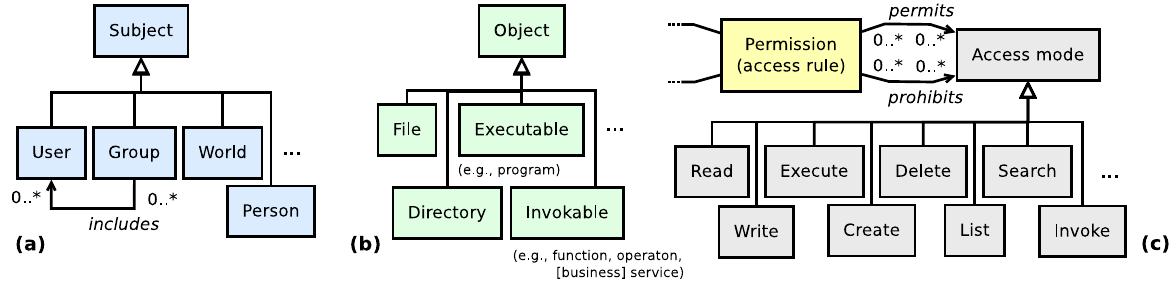
Figure 1. Subject, object, access mode – the most basic terms of access control, exemplified Table 1. Summary of access control models, policies and mechanisms